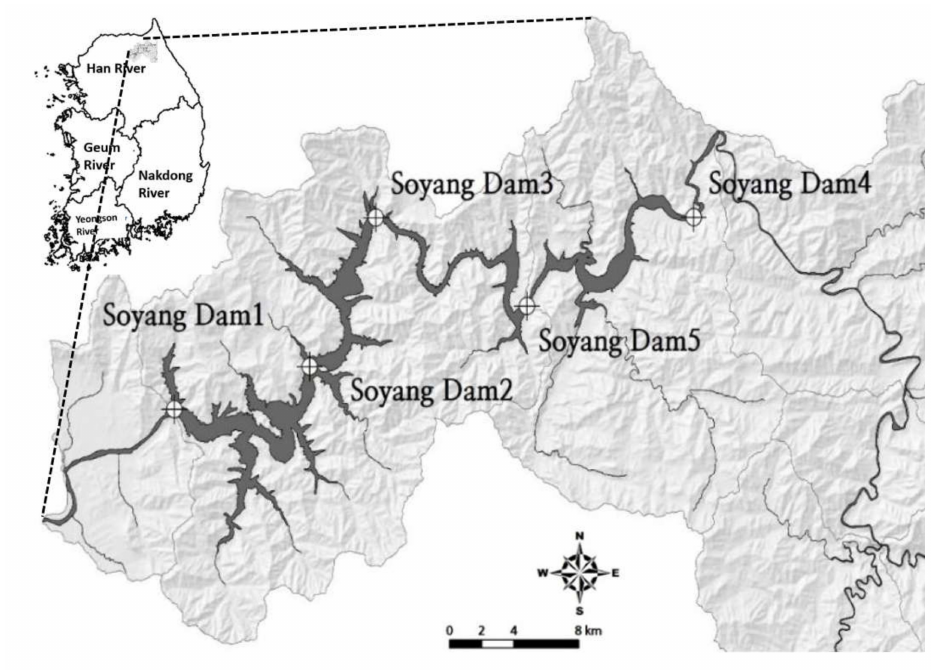
Figure 1. Study area map showing the dendritic-shape Soyang Reservoir, the topography of the reservoir watershed, and the five sampling sites indicated by crossed